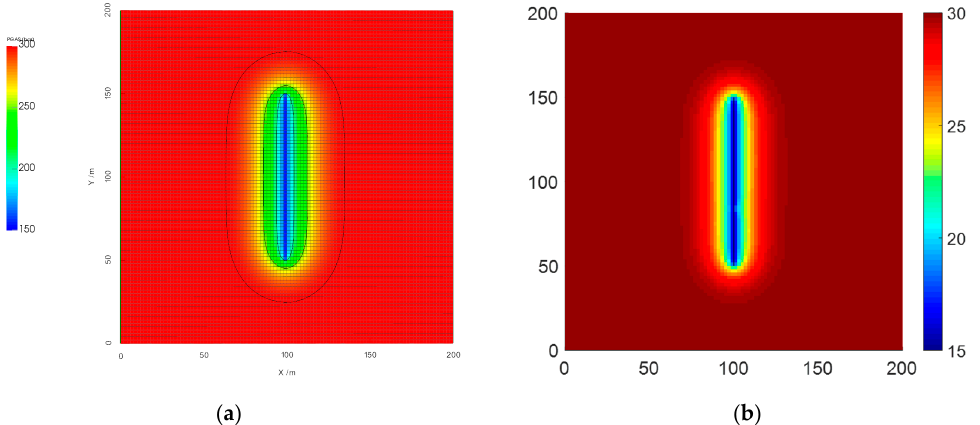
Figure 4. Cumulative production (model vs. Uncong).